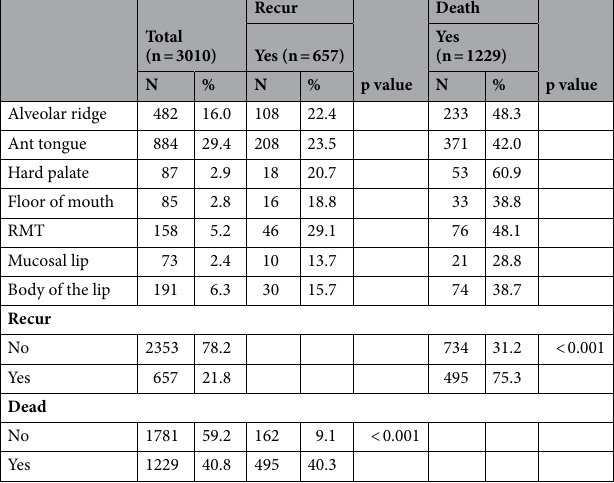
Cox proportional-hazards regression analysis of disease free survival Univariate analysis